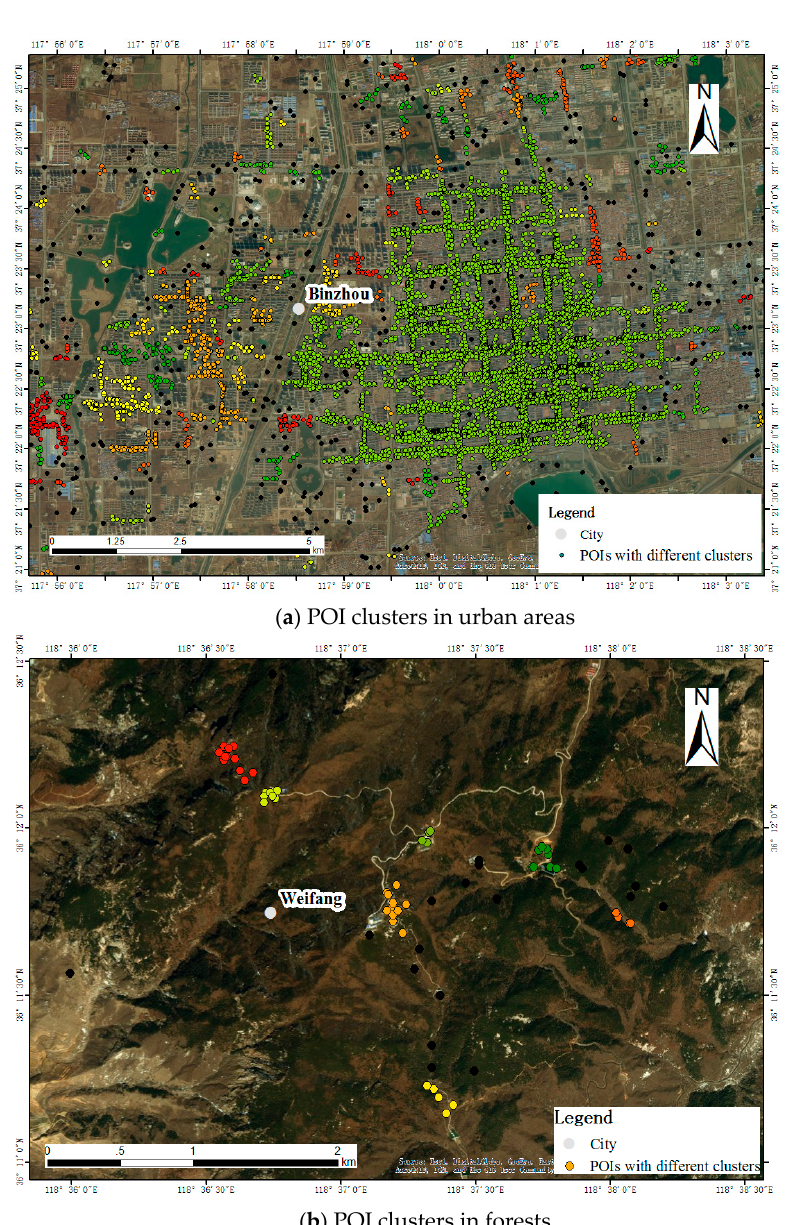
Figure 10. Results of POI clusters in two areas in Shandong Province.